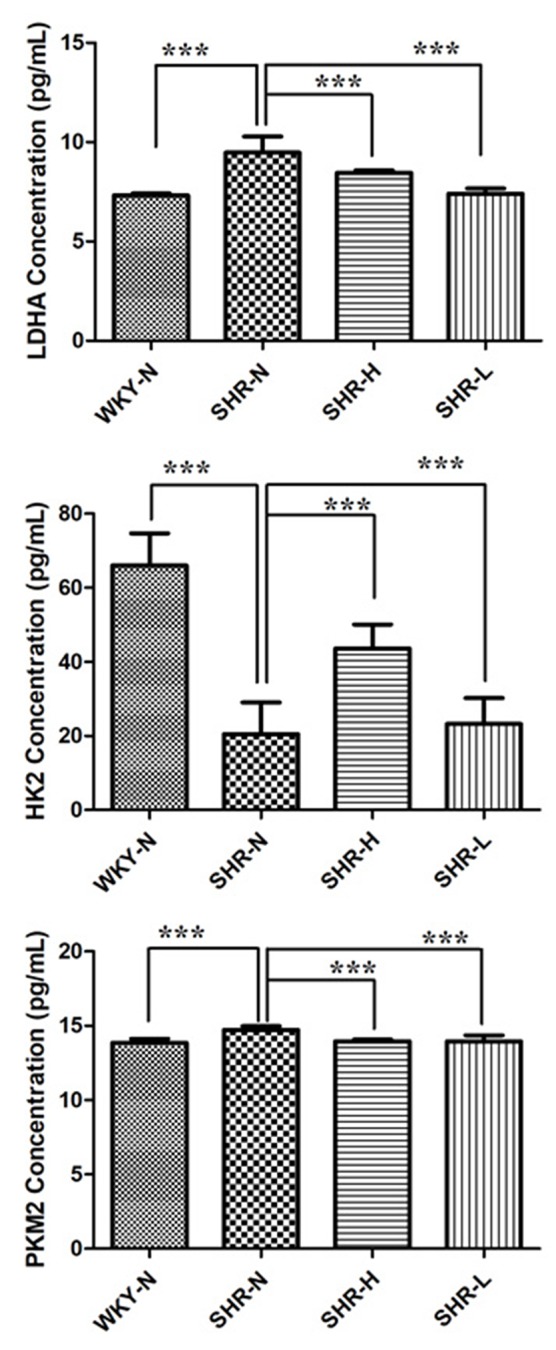
Expressions of glycolysis-related enzymes after treatment with TSC. Data are expressed as the mean ± SD and were analyzed by ANOVA. ***p < 0.0001.